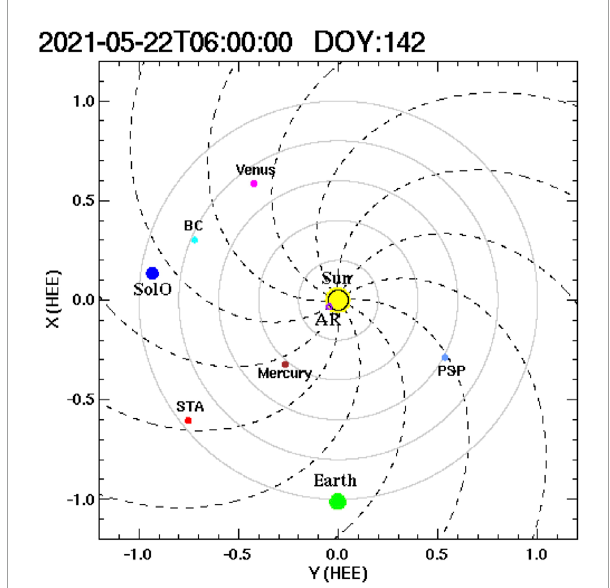
FIGURE 2 The location of Solar Orbiter on 22 May 2021 with respect to the Sun and Earth. Other observatories and planets are also included. The rough position of AR 12824 is indicated as “AR”. Dashed curves are the nominal Parker Spiral for the assumed constant solar wind velocity of 400 km s −1 .